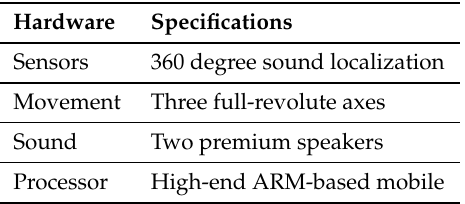
Table 1. Hardware specifications of JIBO